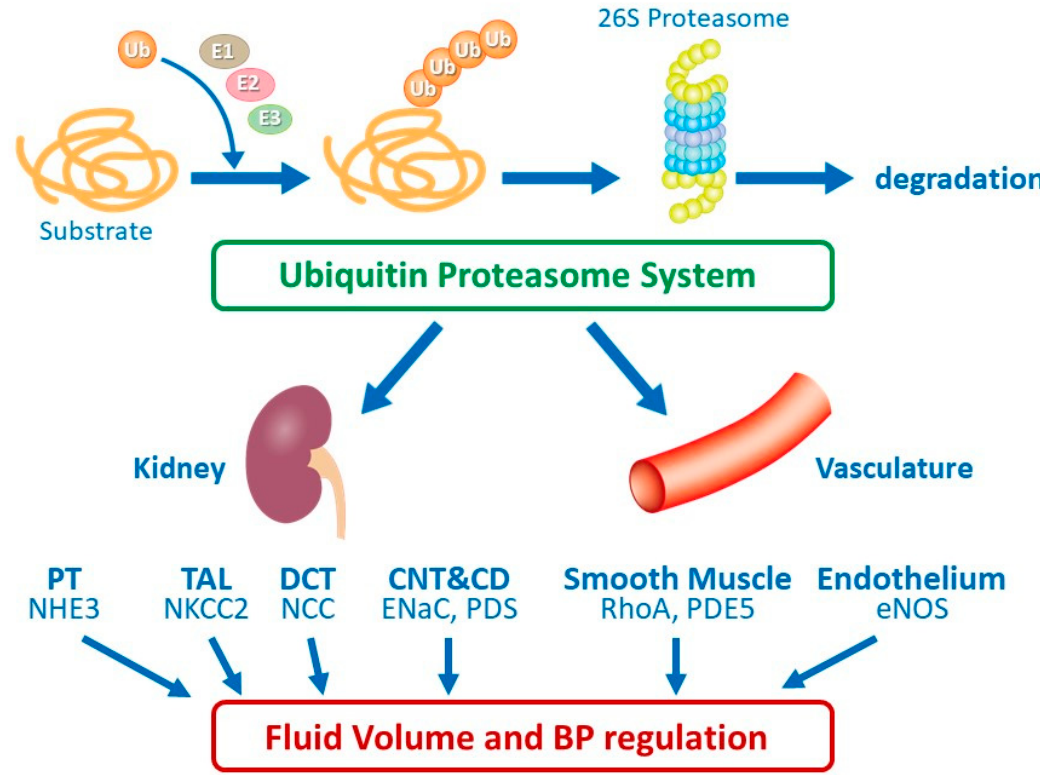
Figure 1. The role of ubiquitin proteasome system in fluid volume and blood pressure regulation. PT, proximal tubule; TAL, thick ascending limb; DCT, distal convoluted tubule; CNT, connecting tubule; CD, collecting duct.